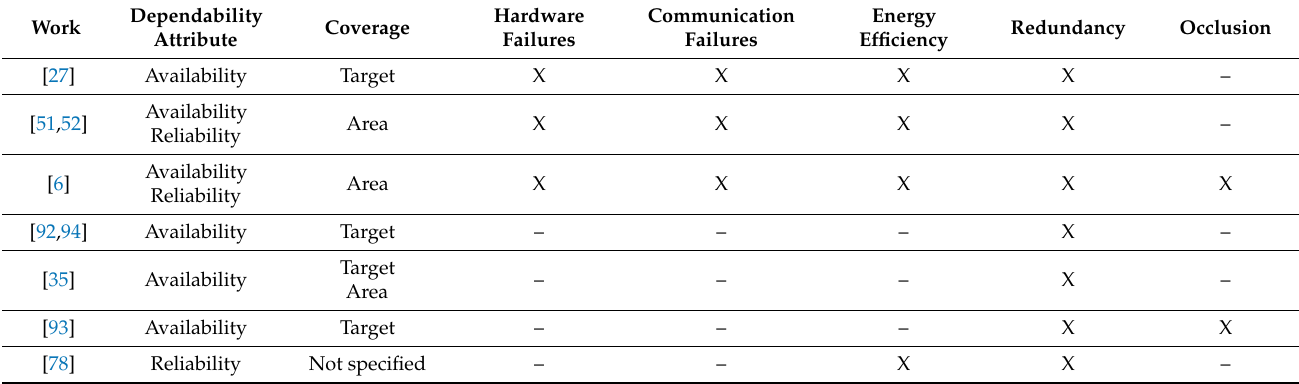
Table 3. Summary of the performed dependable quality